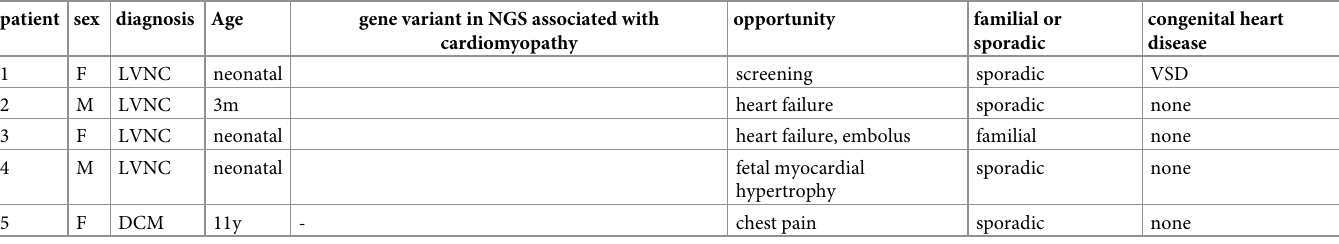
Table 1. Characteristics of the patients carrying the heterozygous TBX5 c.791G > A, R264K variant. patient sex diagnosis Age gene variant in NGS associated with